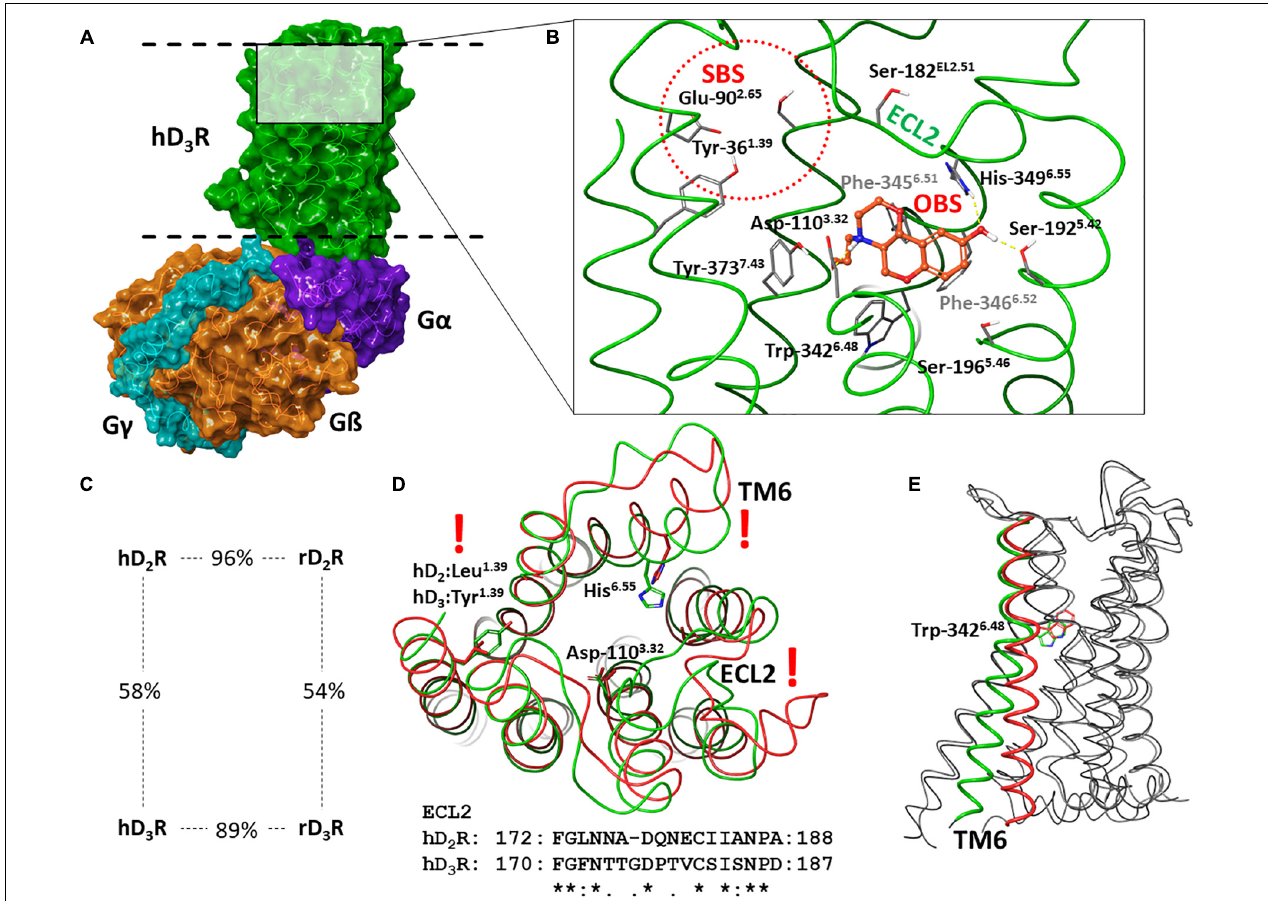
FIGURE 1 | Structure of hD 3 R: (A) hD 3 R-G i complex; (B) binding of the selective agonist PD128907 in the orthosteric binding site (Secondary binding site and ECL2 are also depicted); (C) percent identity of human and rat D 2 R and D 3 R sequences; (D) comparison of hD 2 R (red) and hD 3 R (green); (E) comparison of active (green) and inactive (red) conformation of hD 3